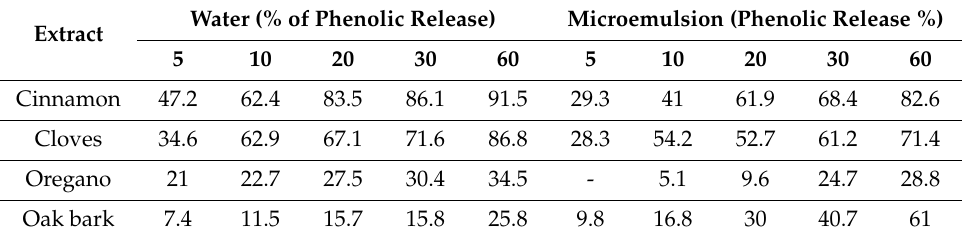
Table 5. Short-term stability and release of phenolics from fibers in water and emulsion.